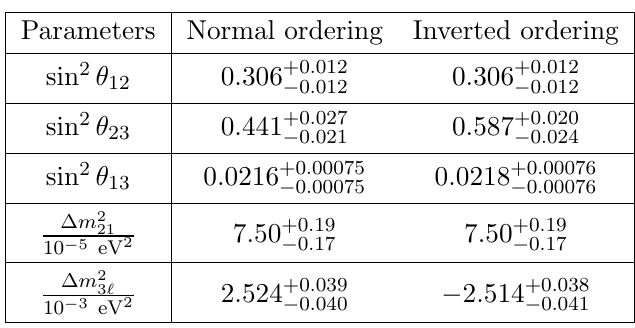
Table 2 . Latest values of the neutrino oscillation parameters within 3 (cid:27) [1] error range. Note that, ‘ = 1 ; 2 for normal and inverted hierarchies